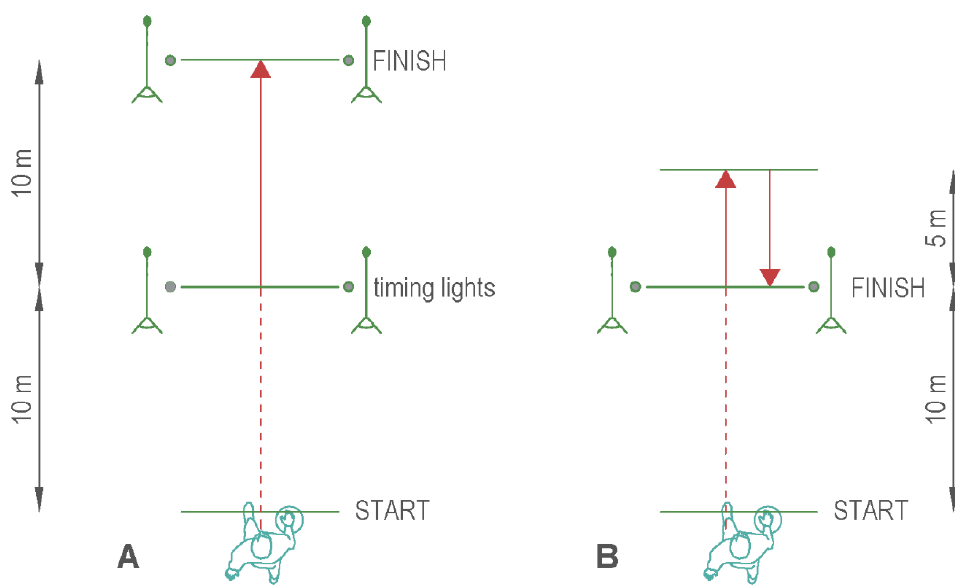
Figure 15. Layout of the ( A ) 20 m linear sprint and ( B ) Agility-505 test; adapted and edited from [97] .